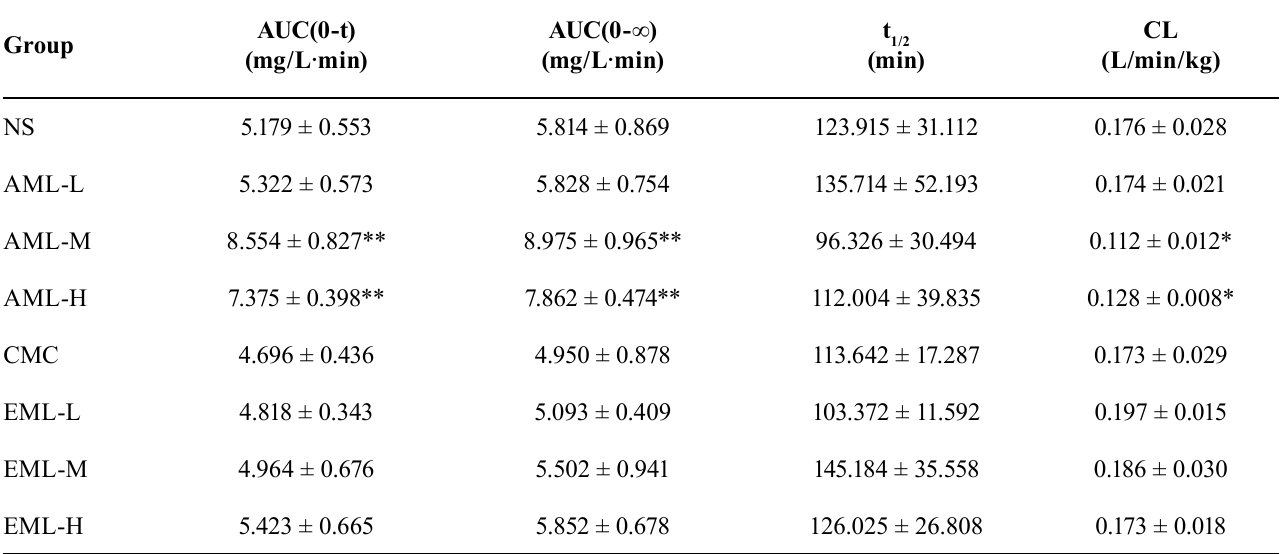
TABLE VII – Main pharmacokinetic parameters of amodiaquine in rats (n=6, mean ± SD)